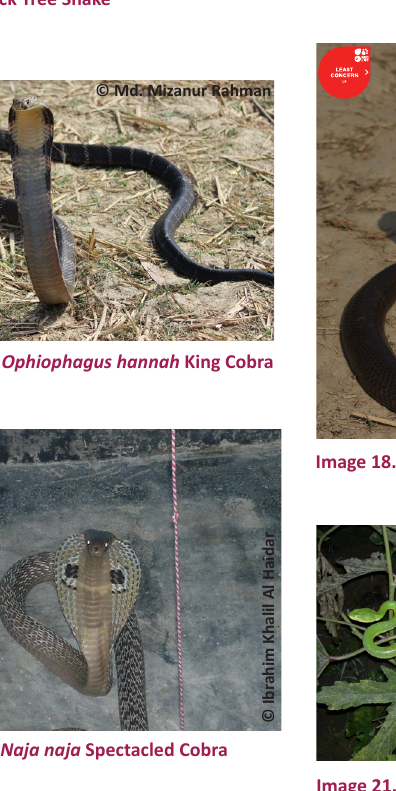
Image 15. Ptyas mucosa Indian Rat